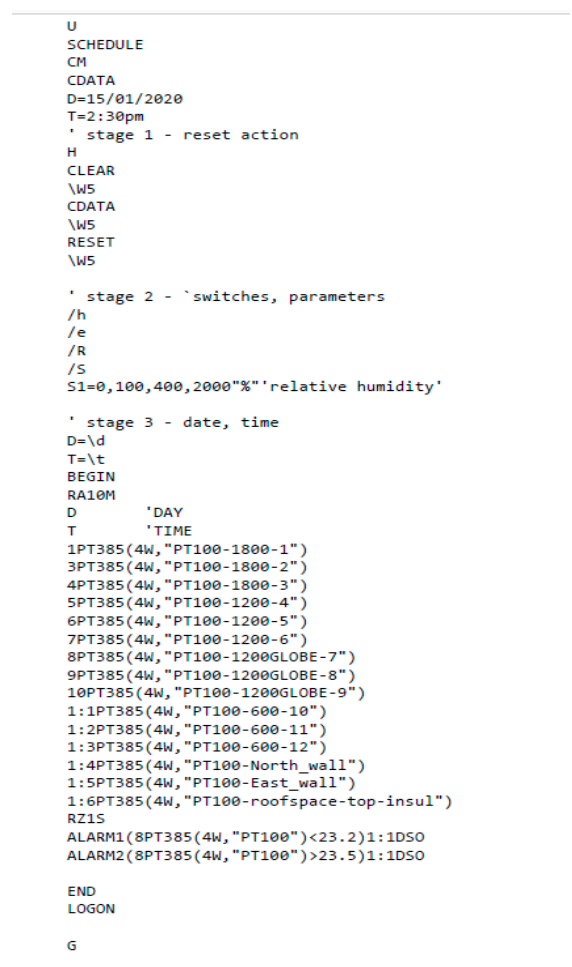
Figure 15. Example of temperature programming code.